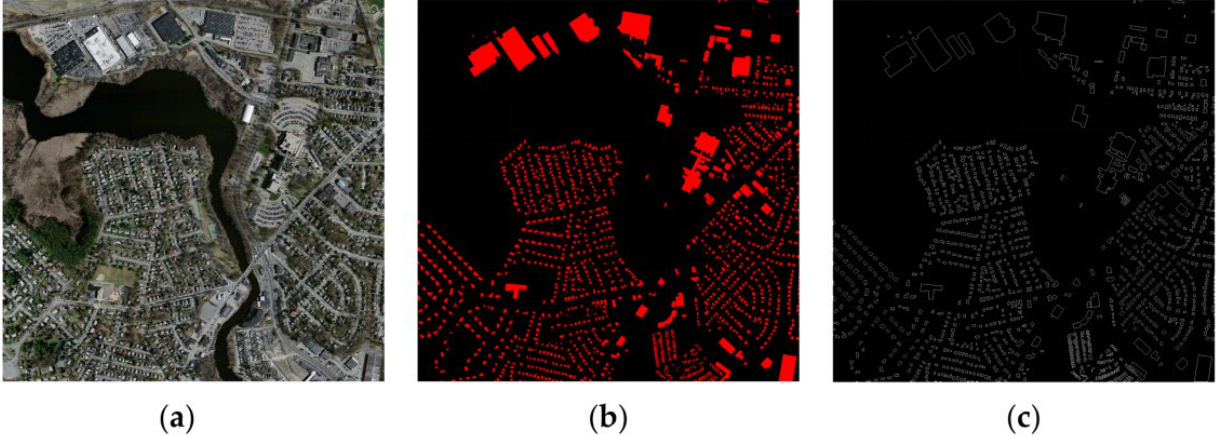
Figure 2. Samples of Massachusetts Building Dataset: ( a ) original image; ( b ) original building regions label; ( c ) building edges label.